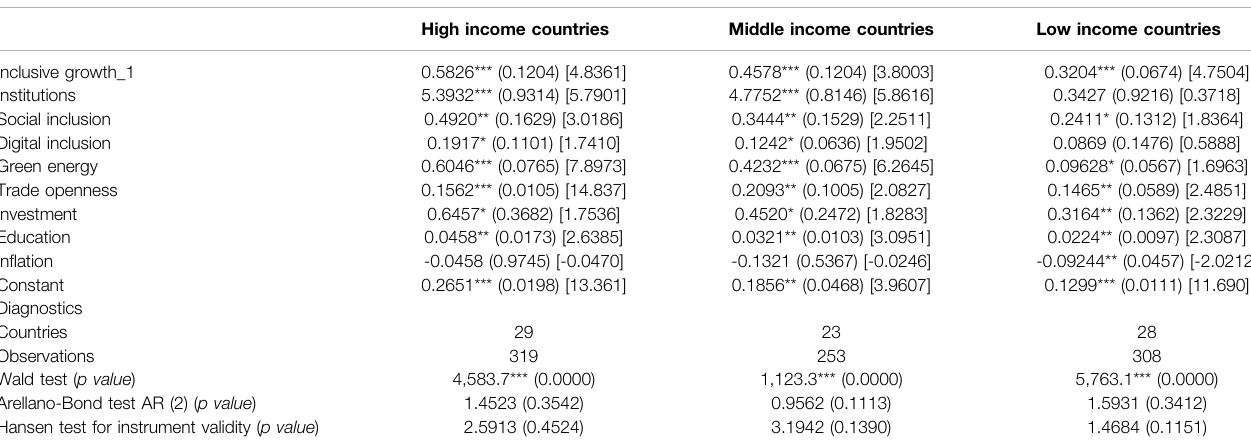
TABLE 1 | Results without interaction